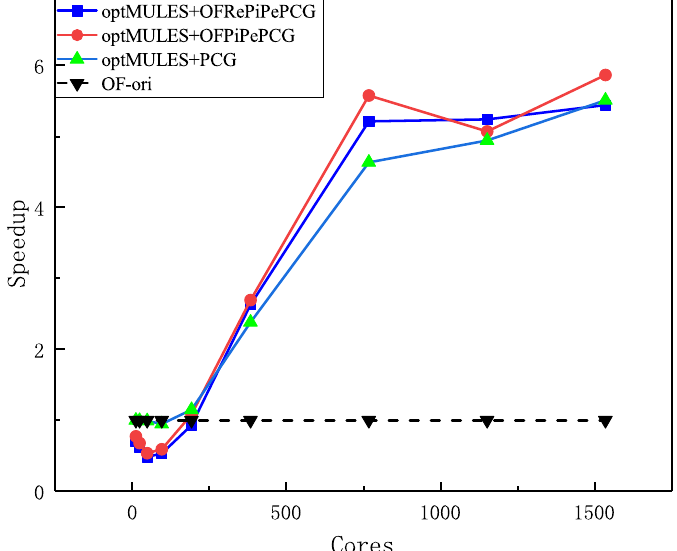
Figure 12. Strong scaling speedups relative to OF-ori (damBreak). The OF-ori means Original